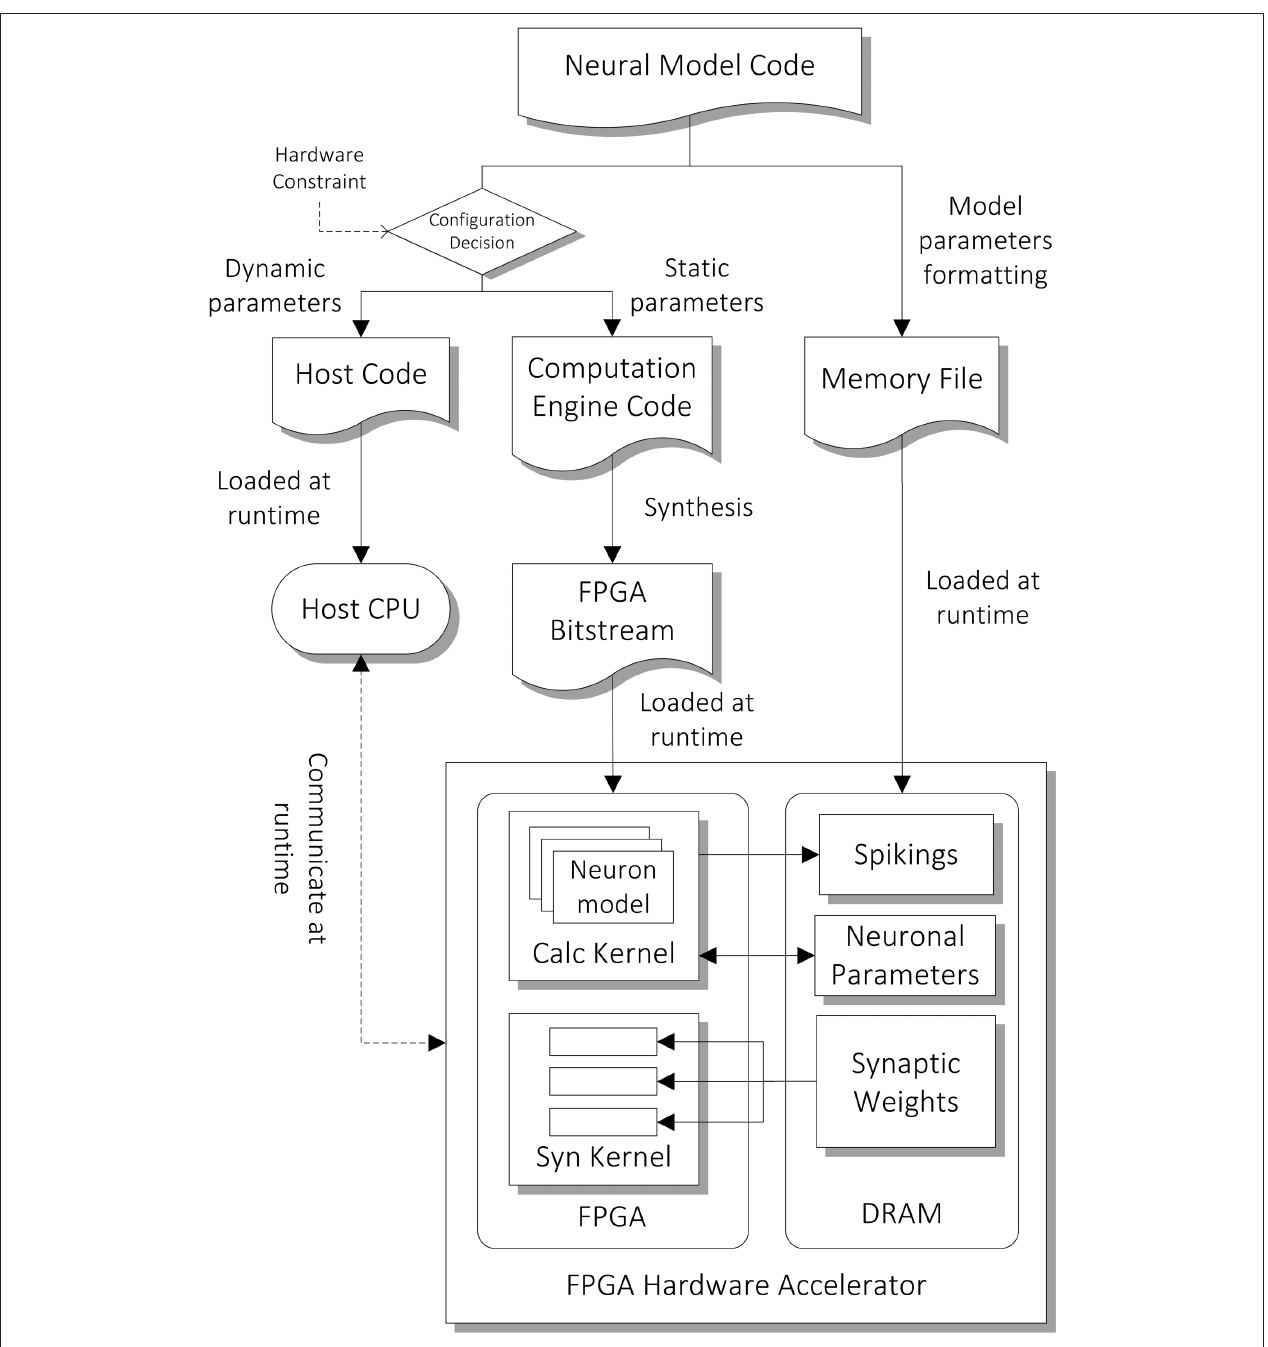
FIGURE 3 | Compilation pipeline and runtime file loading of NeuroFlow. The pipeline receives neural model code written in Python which is then compiled into hardware configuration, host side configuration and memory data file. The resulting data files and configurations are loaded into the host processor (CPU) and FPGA of the system during